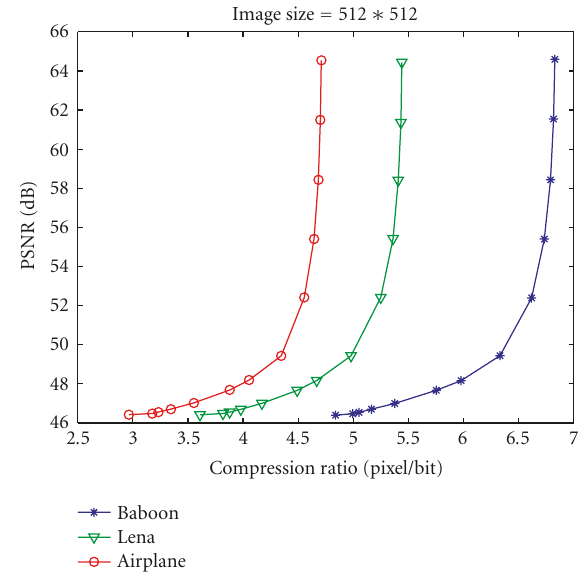
Figure 14: PSNR versus compression rate when the quality control factor varies from one to zero.